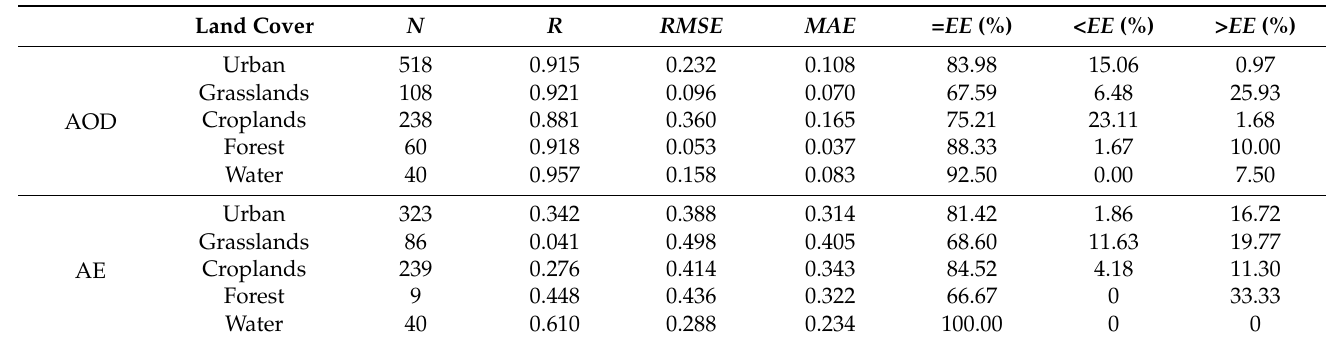
Table 4. Validation of MISR V23 AOD and AE in 0.5 ◦ × 0.5 ◦ resolution over different land covers in